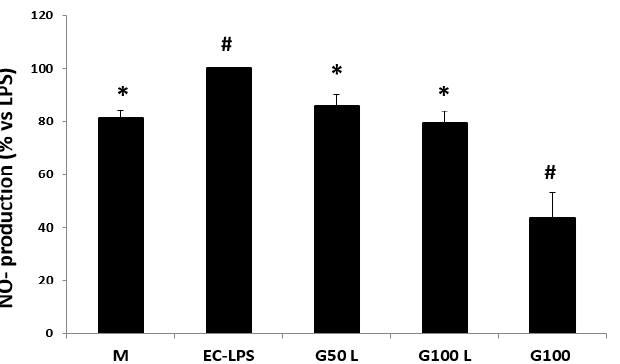
Figure 14. GAAE pre-treatment effect on NO production in UC patients challenged with EC-LPS . Biopsies were treated only with medium culture, or with 1 mg/mL of EC-LPS or pretreated for three h with 50 and 100 µg/mL GAAE, then challenged for 18 h with EC-LPS (G50 L and G100 L), or treated only with 100 µg/mL GAAE (G100). Results are expressed as means ± S.E.M. ( N = 31), * p < 0.05 vs. EC-LPS, # p < 0.05 vs. medium (Student’s t - test).